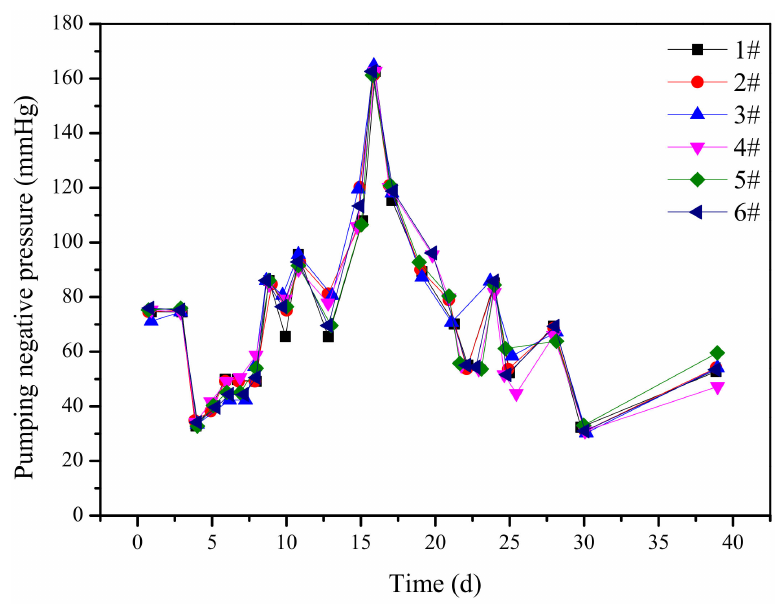
Figure 10. Comparison of 1#–6# borehole gas drainage pumping negative curves. Table 5. Gas drainage concentration of each time period of experimental